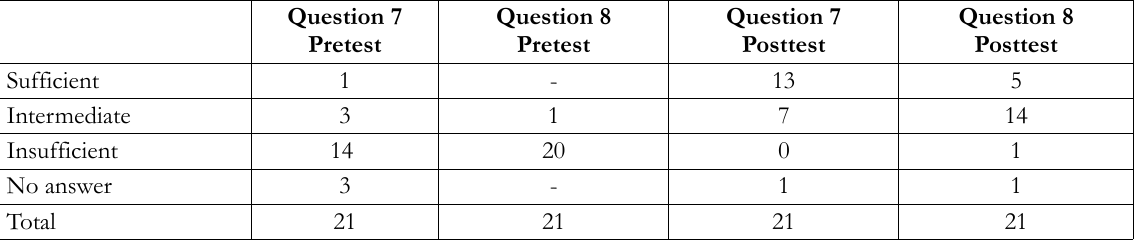
Table 6. The sufficiency of mental representations in responses to questions 7 &